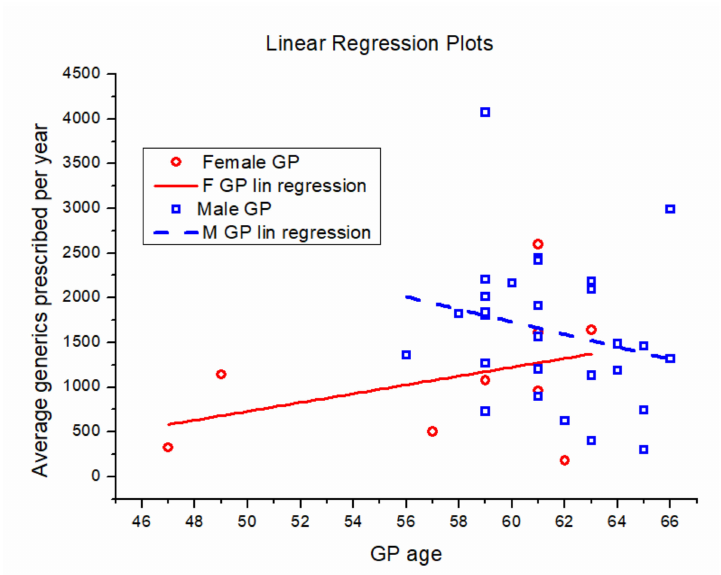
Figure 6. Correlation between average number of generics prescribed per year and GP age (females: red circles; males: blue squares). Full red line: linear regression for females. Dashed blue line: linear regression for